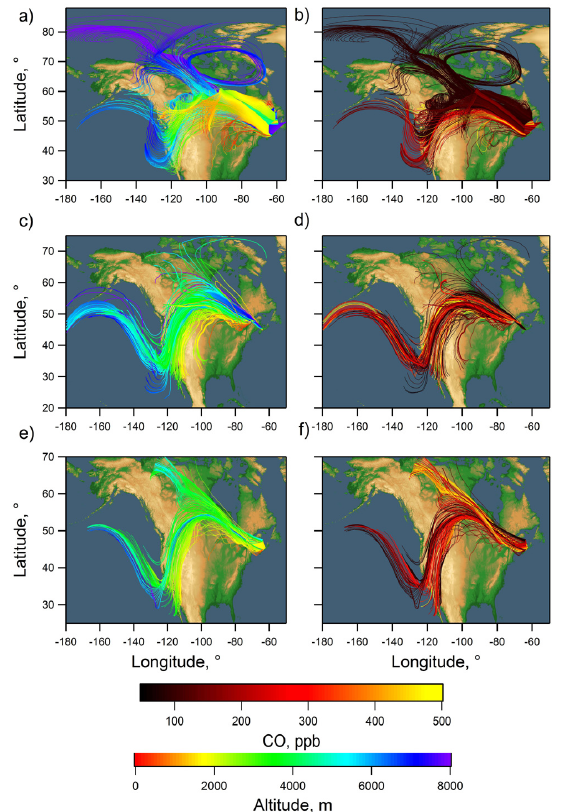
Fig. 6. Five-day HYSPLIT back trajectories whose endpoints co- locate with every minute of the FAAM BAe-146 flight track, for the whole of the flights B621 (a, b) , B622 (c, d) and B623 (e, f) . Panels (a), (c) and (e) have been colour-coded by altitude, while (b), (d) and (f) have been colour-coded by the CO measurement on the FAAM BAe-146 at the endpoint of each